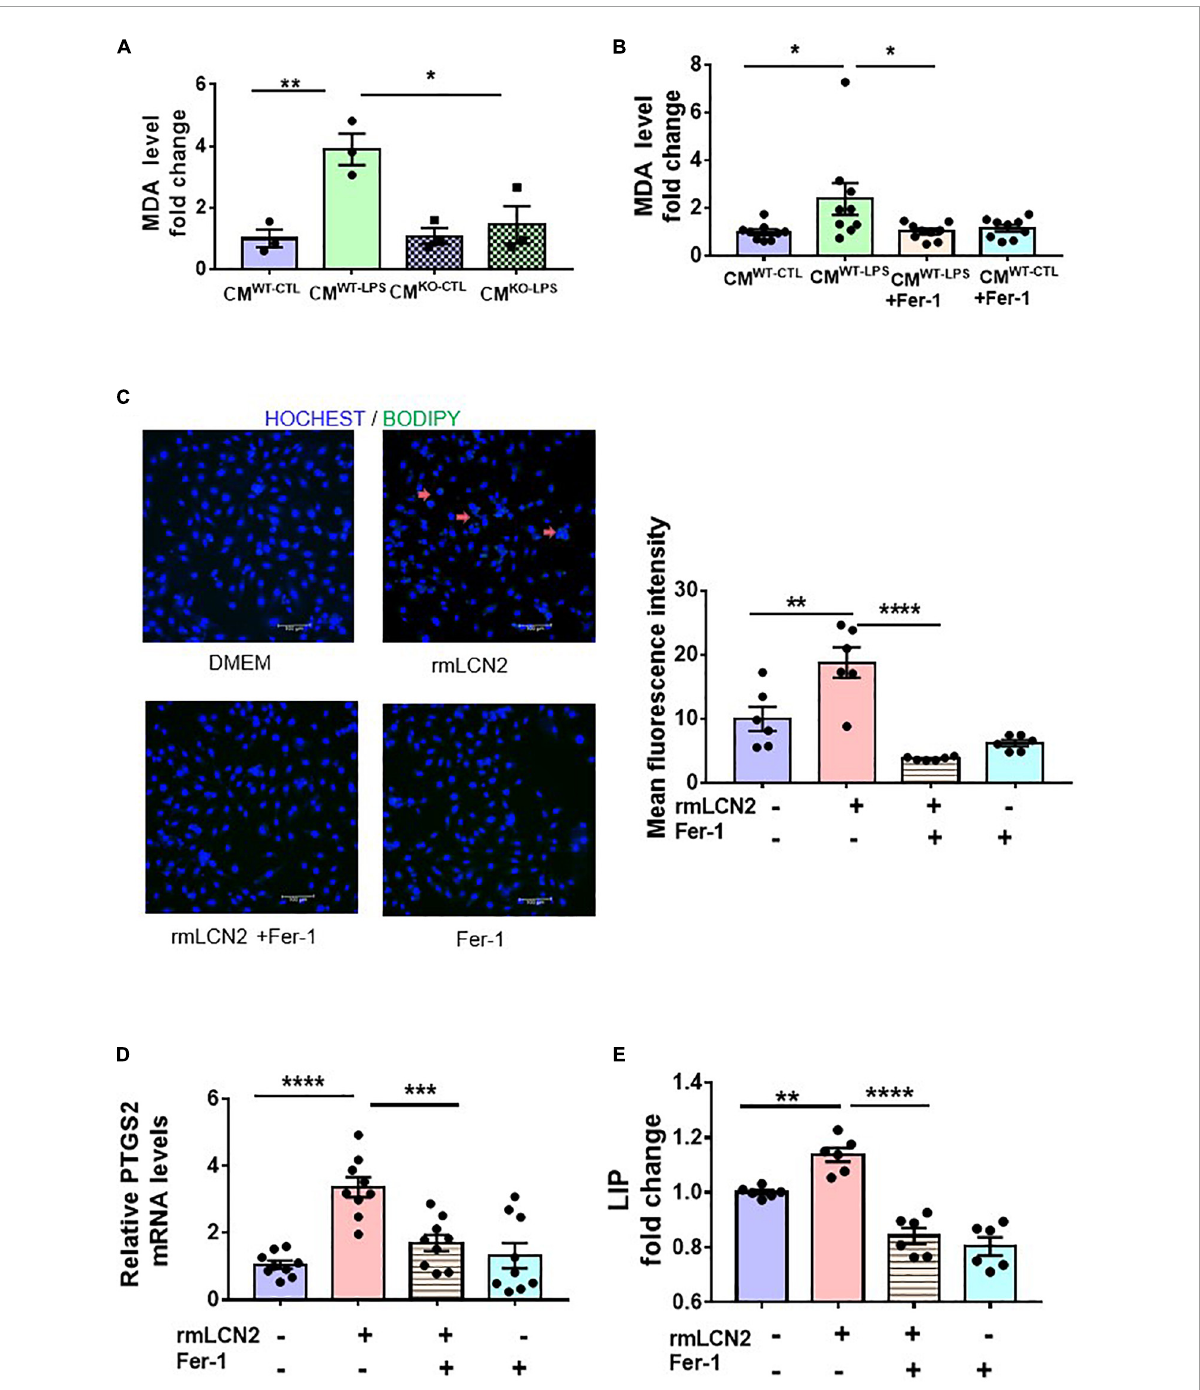
FIGURE3 LCN2 initiated ferroptosis in cardiomyocytes. (A) Neonatal cardiomyocytes were incubated for 24 h with CMs of the neutrophils from either WT littermates without LPS-preconditioning (CM WT − CTL ) or with LPS-preconditioning (CM WT − LPS ), and from LCN2 KO mice without LPS-preconditioning (CM LCN2 − CTL ) or with LPS-preconditioning (CM LCN2 − LPS ) to detect MDA levels ( n = 3 in each group). (B) Neonatal cardiomyocytes were pre-incubated for 2 h with or without Fer-1 (10 µ M) prior to incubation with CMs for 24 h to detect MDA levels ( n = 9 in each group). (C) Representative images and fluorescence intensity analysis of H9C2 cells pre-incubated with or without Fer-1 (10 µ M) for 2 h prior to incubation with rmLCN2 (1 µ g/ml) for 24 h by 581/591C11-BODIPY staining (red arrows indicate the fluorescence staining, n = 3 in each group). (D) PTGS2 mRNA expressions by qPCR in H9C2 cells pre-incubated with or without Fer-1 (10 µ M) for 2 h prior to incubation with rmLCN2 (1 µ g/ml) for 24 h ( n = 9 in each group). (E) Labile iron pool (LIP) changes in H9C2 cells pre-incubated with or without Fer-1 (10 µ M)